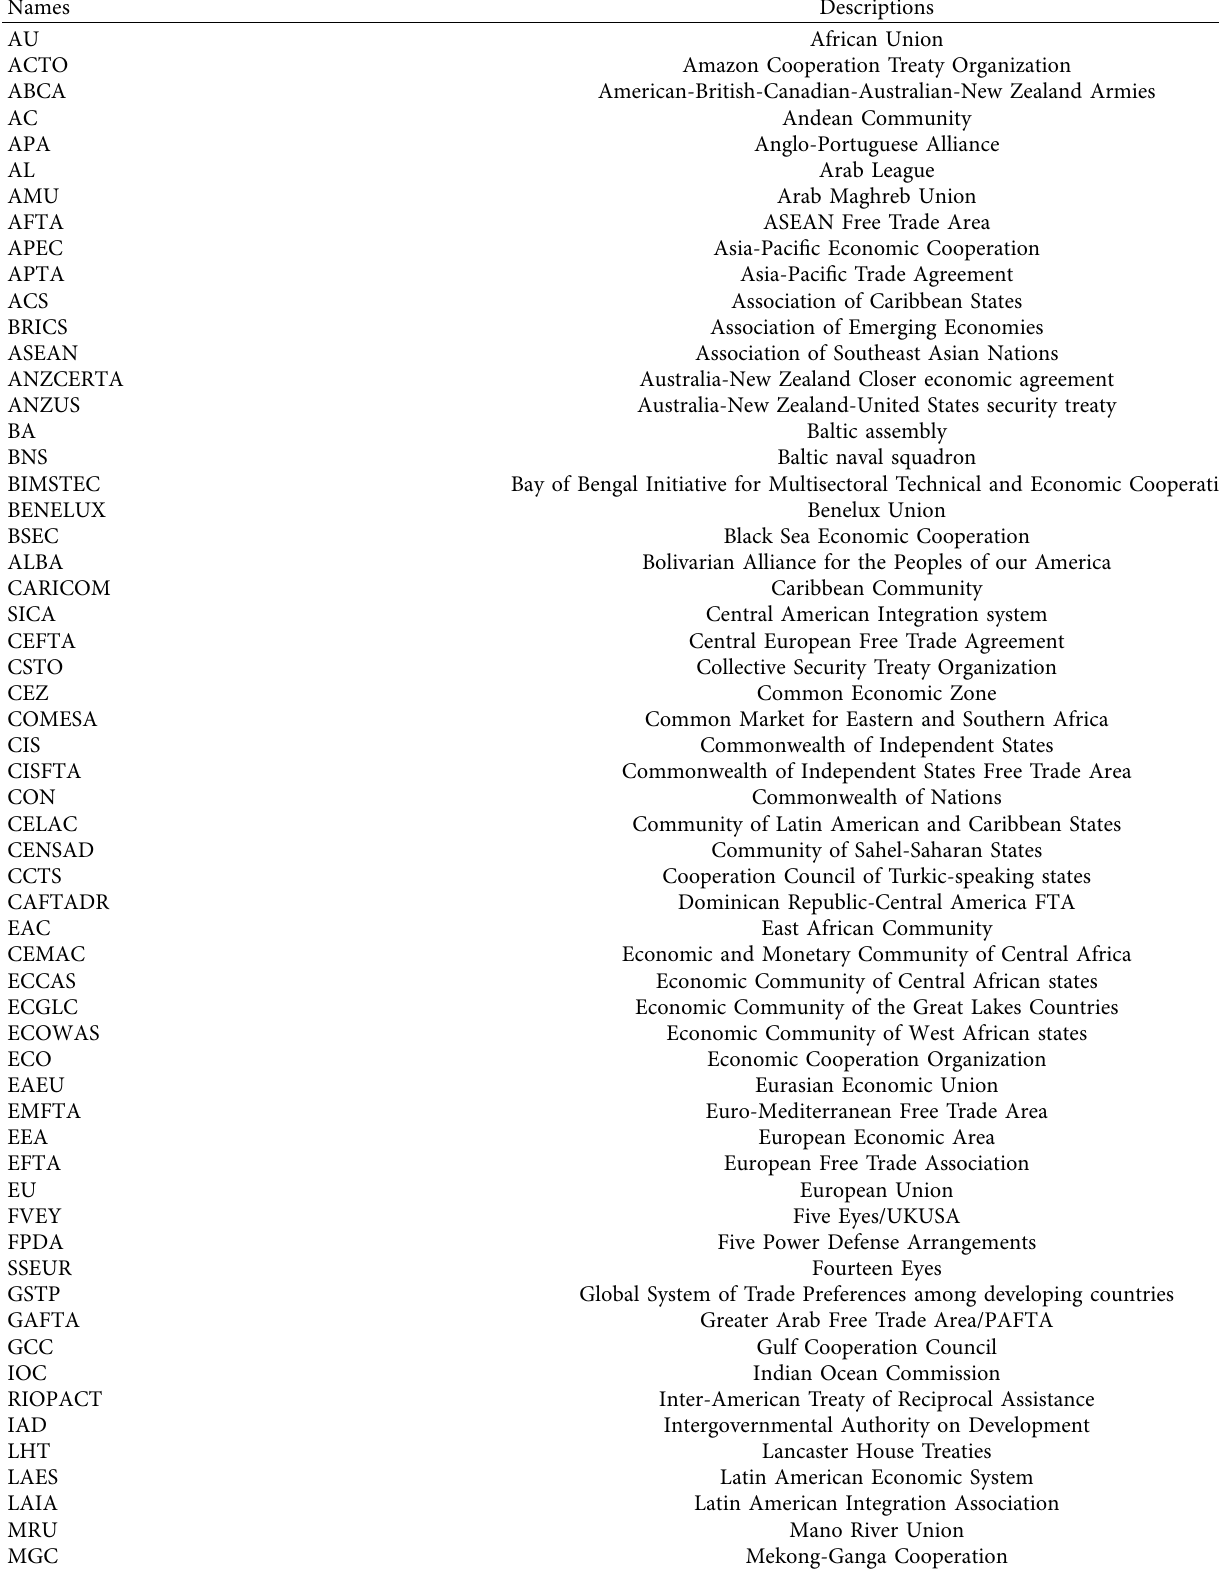
Table 1: List of the geopolitical treaties considered in this